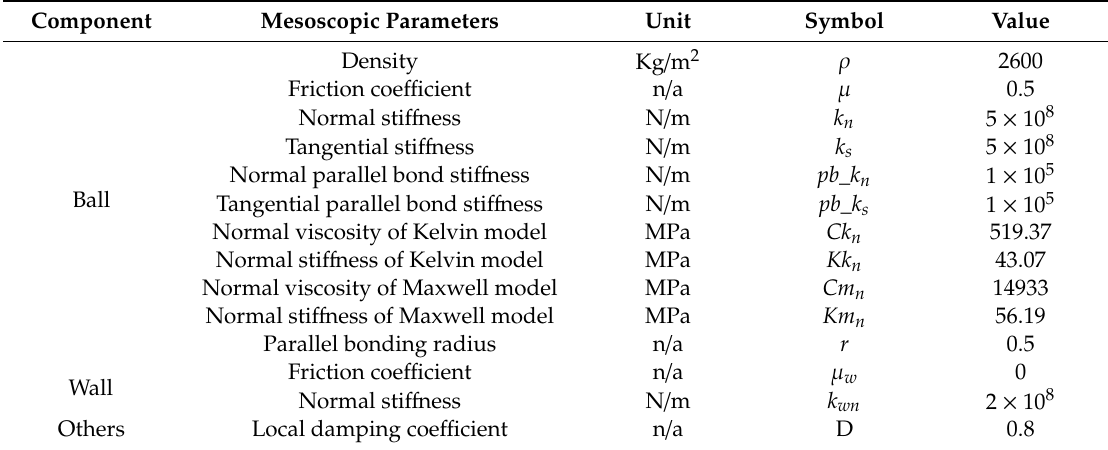
Table 5. Mesoscopic parameters of the two-dimensional mesoscopic model.